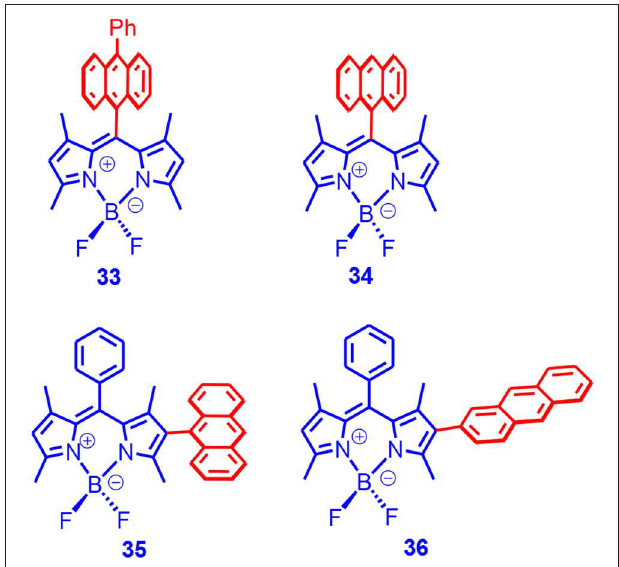
FIGURE 11 | Bodipy derivative with anthryl moiety as electron donor and the dipole moments of the subunits are with parallel or perpendicular. the dipole moments of the two subunits were either in parallel or perpendicular ( Figure 10 ; Wang and Zhao, 2017; Wang et al.,